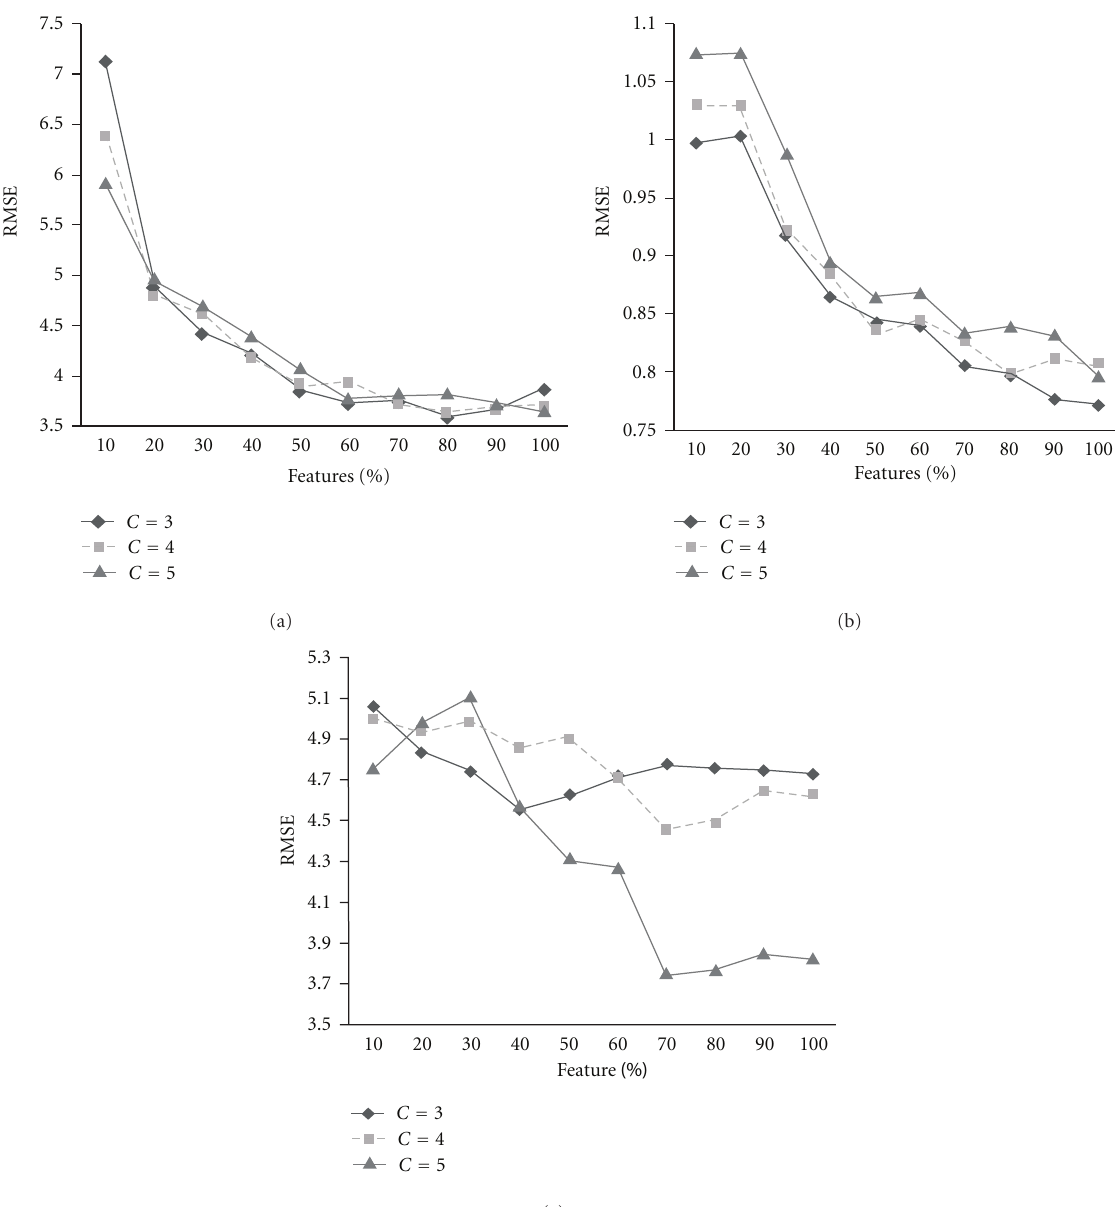
Figure 10: Plots of RMSE versus the percentage of features for selected number clusters: (a) housing data, (b) PM10 data, and (c) body Fat